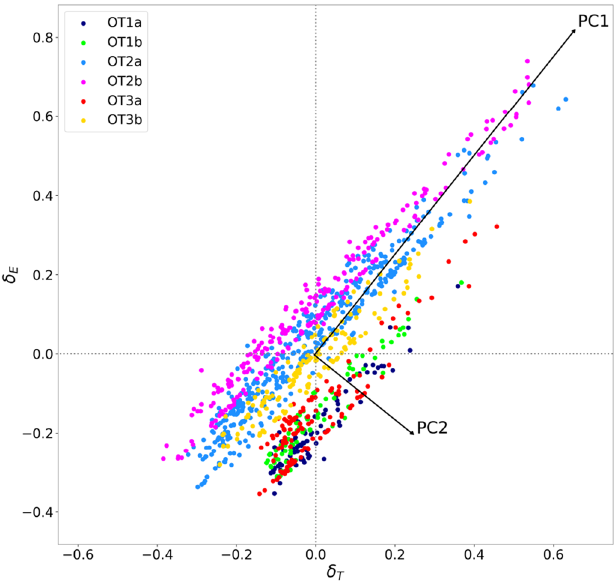
Figure 2. Territorial bias in THE overall ranking. In this scatter plot each dot corresponds to an OECD university, and its coordinates along the horizontal and vertical axes represent the debiasing parameters. The values δ T and δ E assess the results achieved by the institution in the THE overall ranking, respectively by comparison with the rest of the OT and OE community it belongs to. Each dot in the scatter plot is colored according to its OT community membership. The arrangement of different colors in the scatter plot indicates the presence of a territorial bias. The arrows indicate the direction of the principal components PC1 (positive slope) and PC2 (negative slope), with their length proportional to the corresponding standard